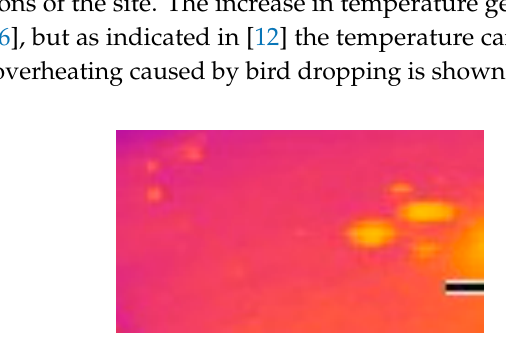
Figure 3. Thermographic image of a PV module with bird droppings.